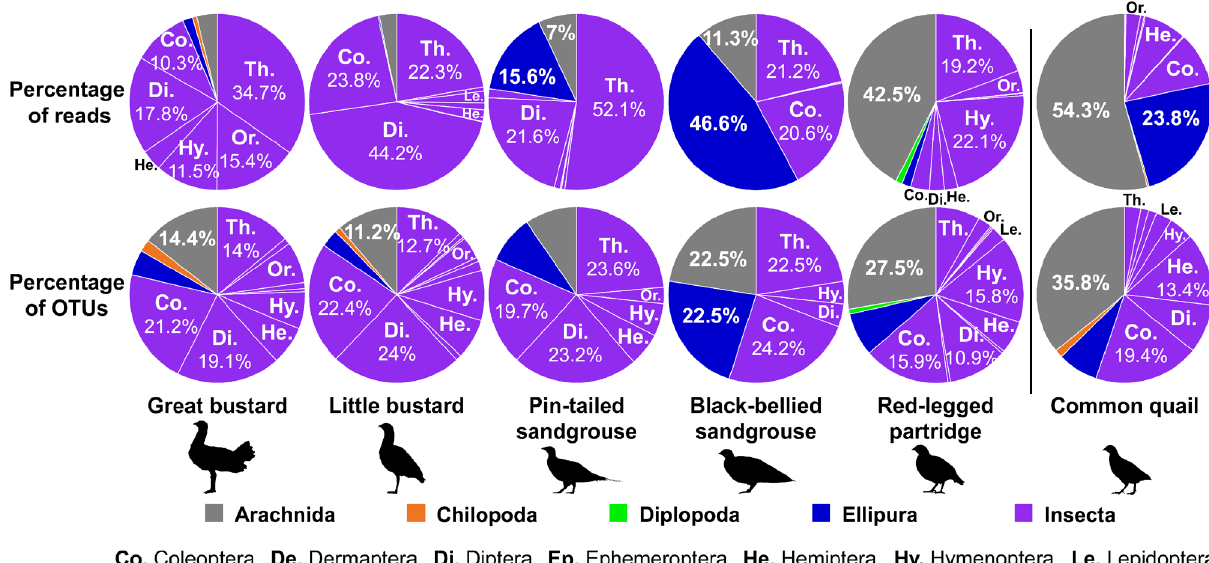
Figure 4. Mean percentage of reads (a measure of abundance) and OTUs (a measure of richness) of each phylum of Arthropoda present on the diet of studied farmland bird species, with phylum Insecta data broken down into orders. Percentages > 10% are detailed numerically. Among Insect’s orders, those with a percentage > 2% are identified. Note that samples of great bustard, little bustard, pin-tailed sandgrouse, black- bellied sandgrouse, and red-legged partridges were collected during the non-breeding season, whereas samples of common quail were collected during the breeding season. The average number of OTUs per species and diet taxa is provided in Supplementary Table S3